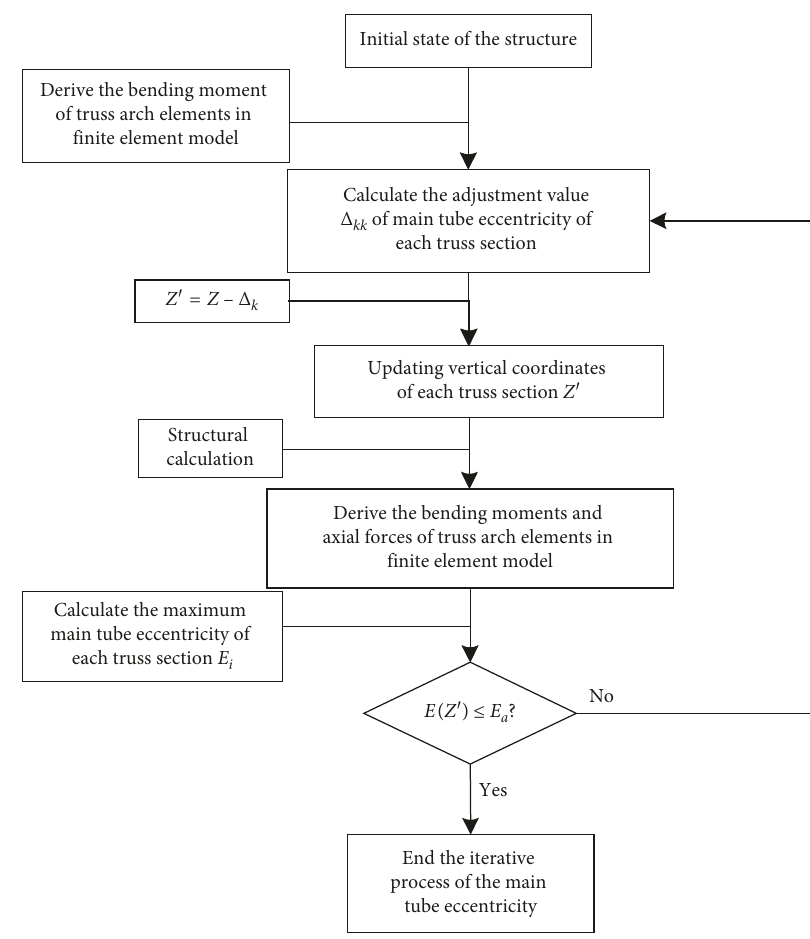
Figure 4: Iterative process of main tube